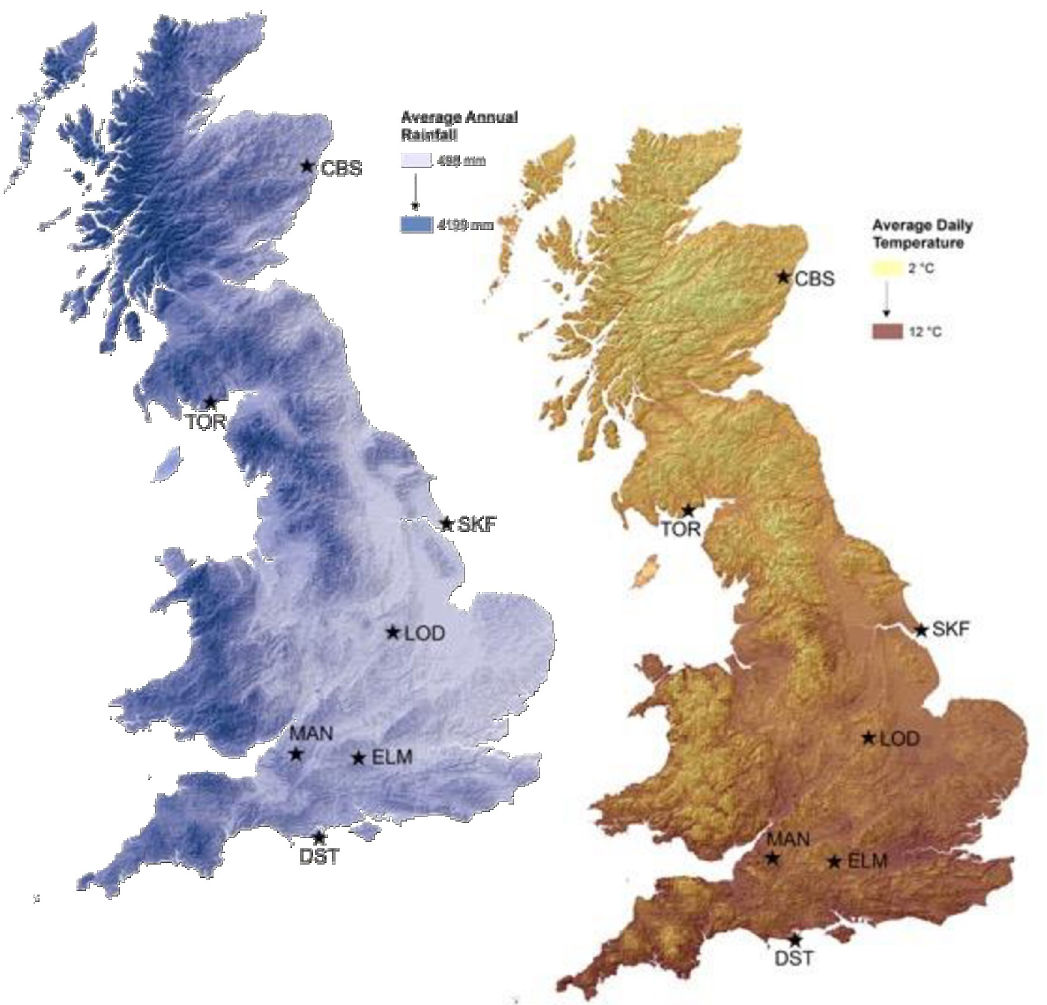
Fig 1. Sampling locations in the UK and their relationship to average annual rainfall and average annual temperature, illustrating the temperature and soil moisture gradient used to help determine the farms sampled. Sampling was carried out at SRUC, Craibstone Aberdeen (CBS), Torr Organic, Dumfries (TOR), Skeffling, Yorkshire (SKF), Loddington, Leicester (LOD), Manor Farm, Somerset (MAN), Elm Farm Berkshire (ELM) and Swanage, Dorset (DST). Figure created by Ron Corstanje, University of Cranfield and released under CC By 4.0